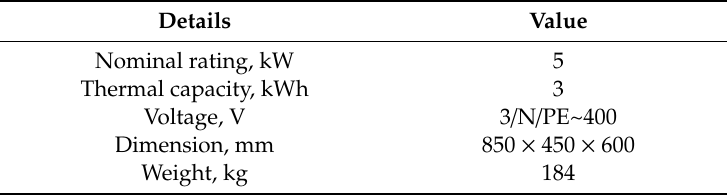
Table 1. Electrical and technical detail of the Electric Thermal Storage (ETS)